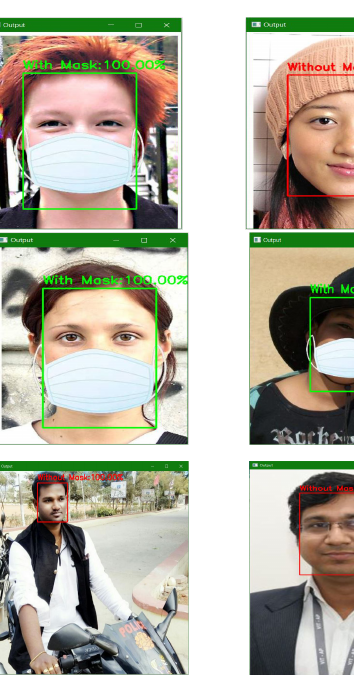
Figure 10. Face detection with and without masks in photo images.